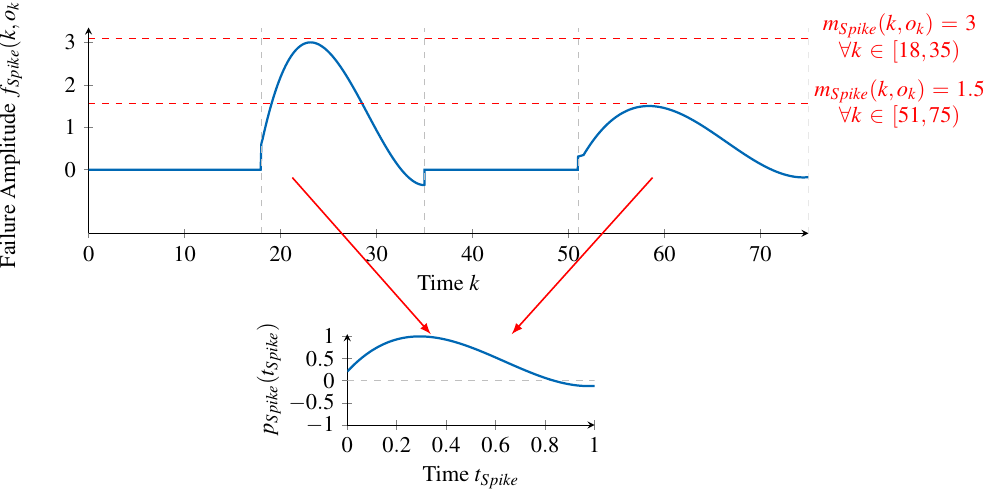
Figure 5. Example of a Spike failure type with two occurrences, modeled through a failure pattern and a stochastic